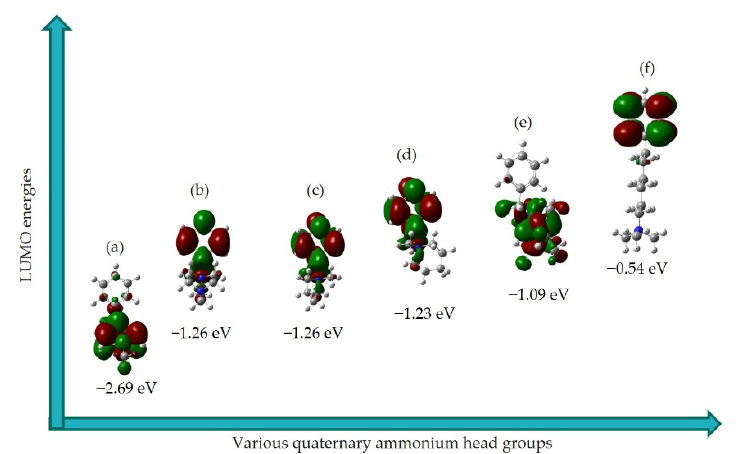
Figure 5. Representation of LUMOs’ density for optimized ground state geometries of QA head groups ( a – f ). Surface |Isovalue| = 0.02 a.u. The green and red colors represent the distribution of LUMOs. Color key: white (hydrogen); grey (carbon); blue (nitrogen); green (chloride).